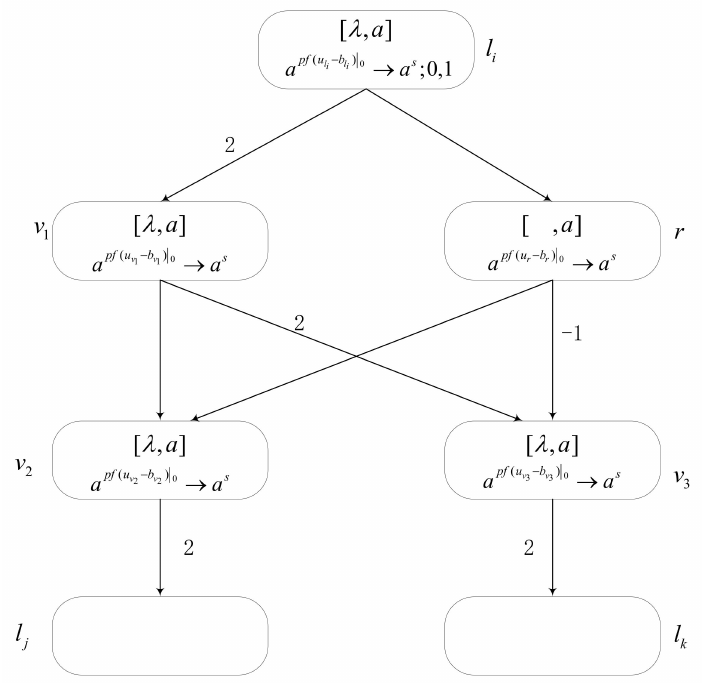
Figure 6. Module SUB. Its function is to simulate SUB instruction l i : ( SUB ( r ) , l j , l k )